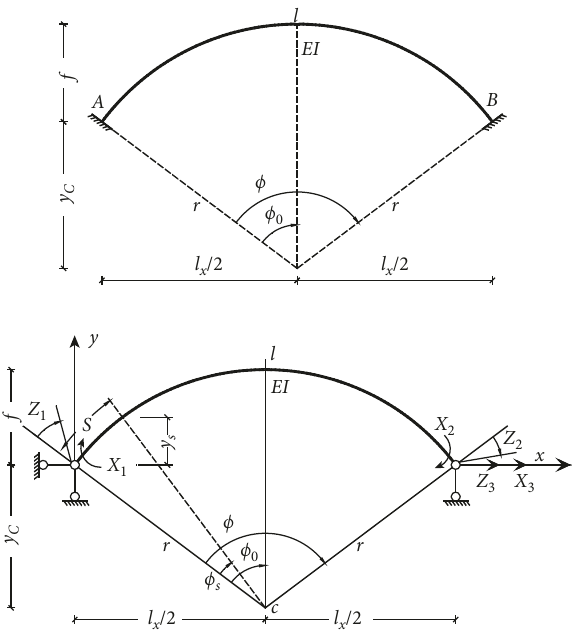
Figure 6: The statical system of the circular arch and the proposed main